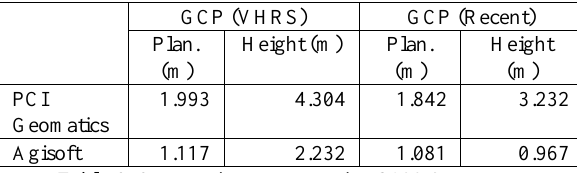
Table 6. Geometric accuracy using S100